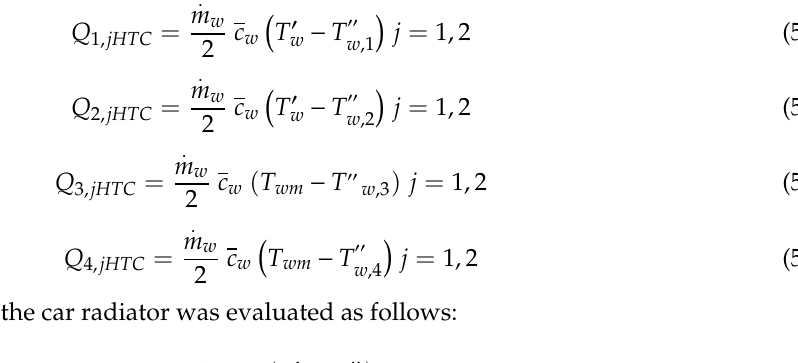
(cid:48) = 60.51 ◦ C, 4: the relative di ff erence between Q w , w